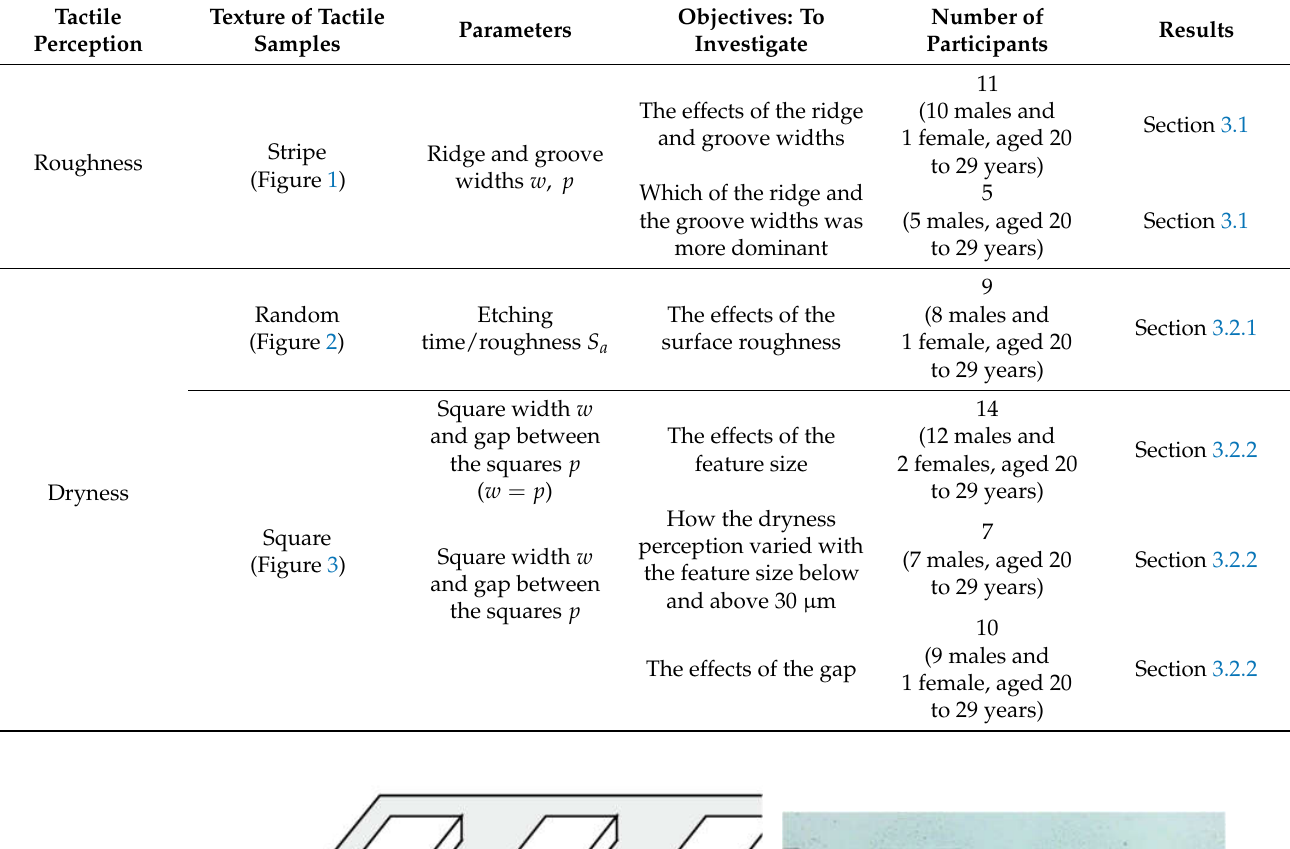
Table 1. Summary of the experiments.